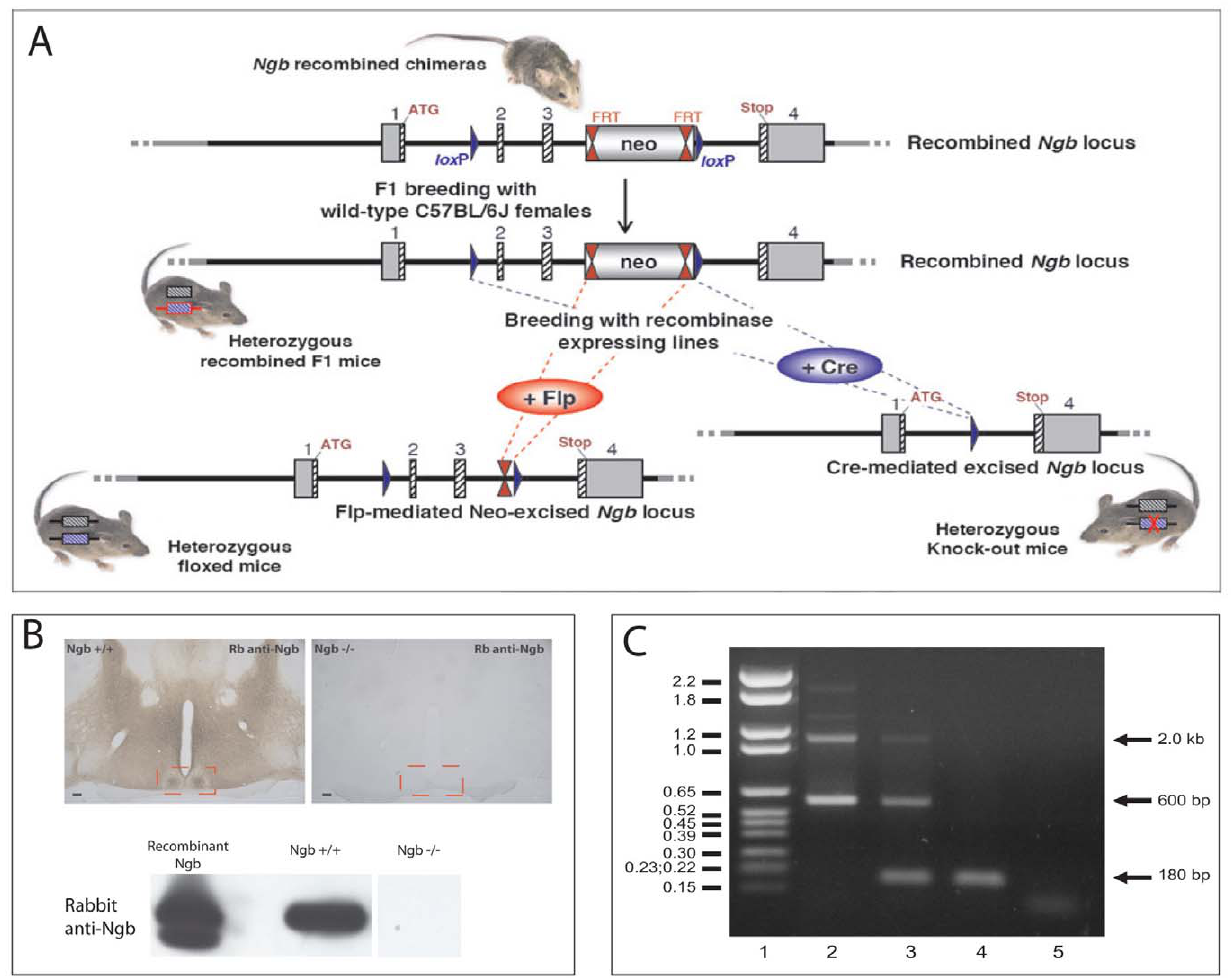
Figure 1. Generation and characterization of Ngb deficient mice. A. Schematic representation of the targeting construct introduced into 129Sv/Pas embryonic stem (ES) cells to generate Ngb-knockout mice. Chimeric mice were crossed with Flp recombinase-expressing mice to remove the Neo resistance cassette and obtain F1 founder mice. F1 founder mice were crossed with mice expressing Cre recombinase ubiquitously which resulted in the deletion of Ngb exons 2 and 3 (B–C). B. Coronal sections of Ngb + / + and Ngb 2 / 2 mice stained with rabbit anti-Ngb antiserum demonstrate specific staining in the Ngb wild type mouse and no staining in Ngb deficient mice. Similar results are obtained when tissue extracts from brains from the two genotypes were analyzed by western blotting (lower panel B). C represents PCR genotyping of littermates obtained by crossing heterozygous Ngb mice. Lane 1: DNA molecular marker VI (Roche), the sizes in kb are indicated into the left, lane 2: PCR on DNA from + / + mouse, the expected size of bands are 2.0 kb and 600 bp, lane 3: PCR on DNA from + / 2 mouse, lane 4: PCR on DNA from Ngb 2 / 2 mouse, expected band size 180 bp; lane 5: Non-template control.